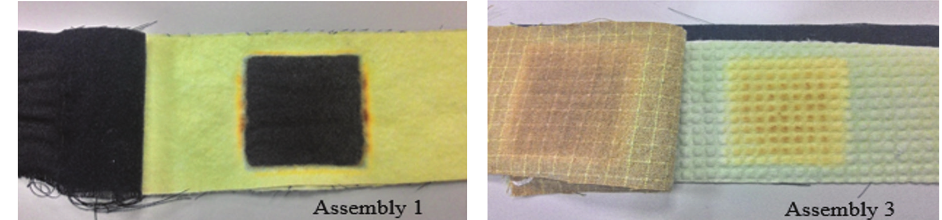
Figure 4: Images of Assembly 1 and Assembly 3 after being exposed to a source of radiant heat.